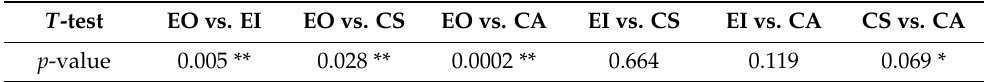
Table 6. T -test results of statistical significance in differences between AUC values shown in Table